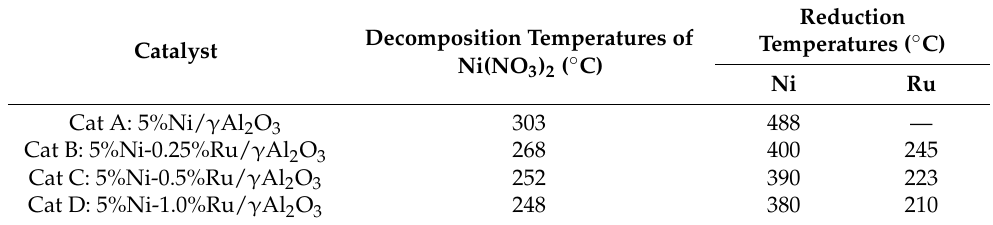
Table 1. Decomposition temperatures of Ni(NO 3 ) 2 and reduction temperatures of NiO and RuO 3 .